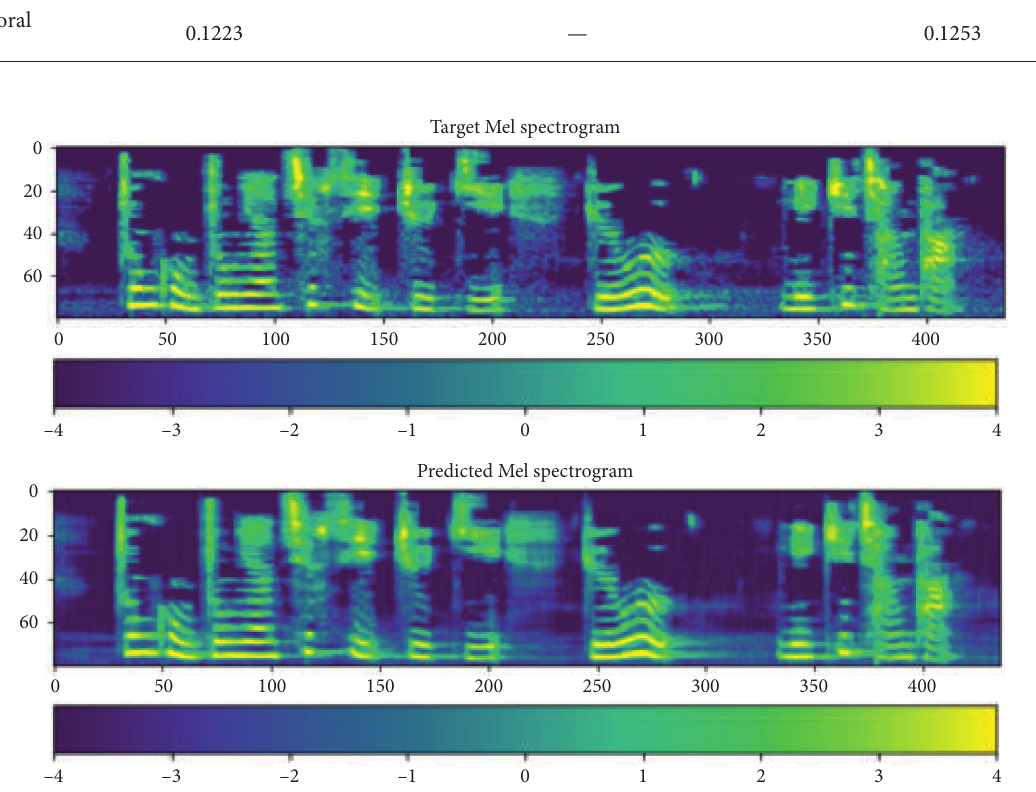
Figure 6: The comparison of the output Mel spectrogram and the target Mel spectrogram of Lhasa- ¨U-Tsang dialect.